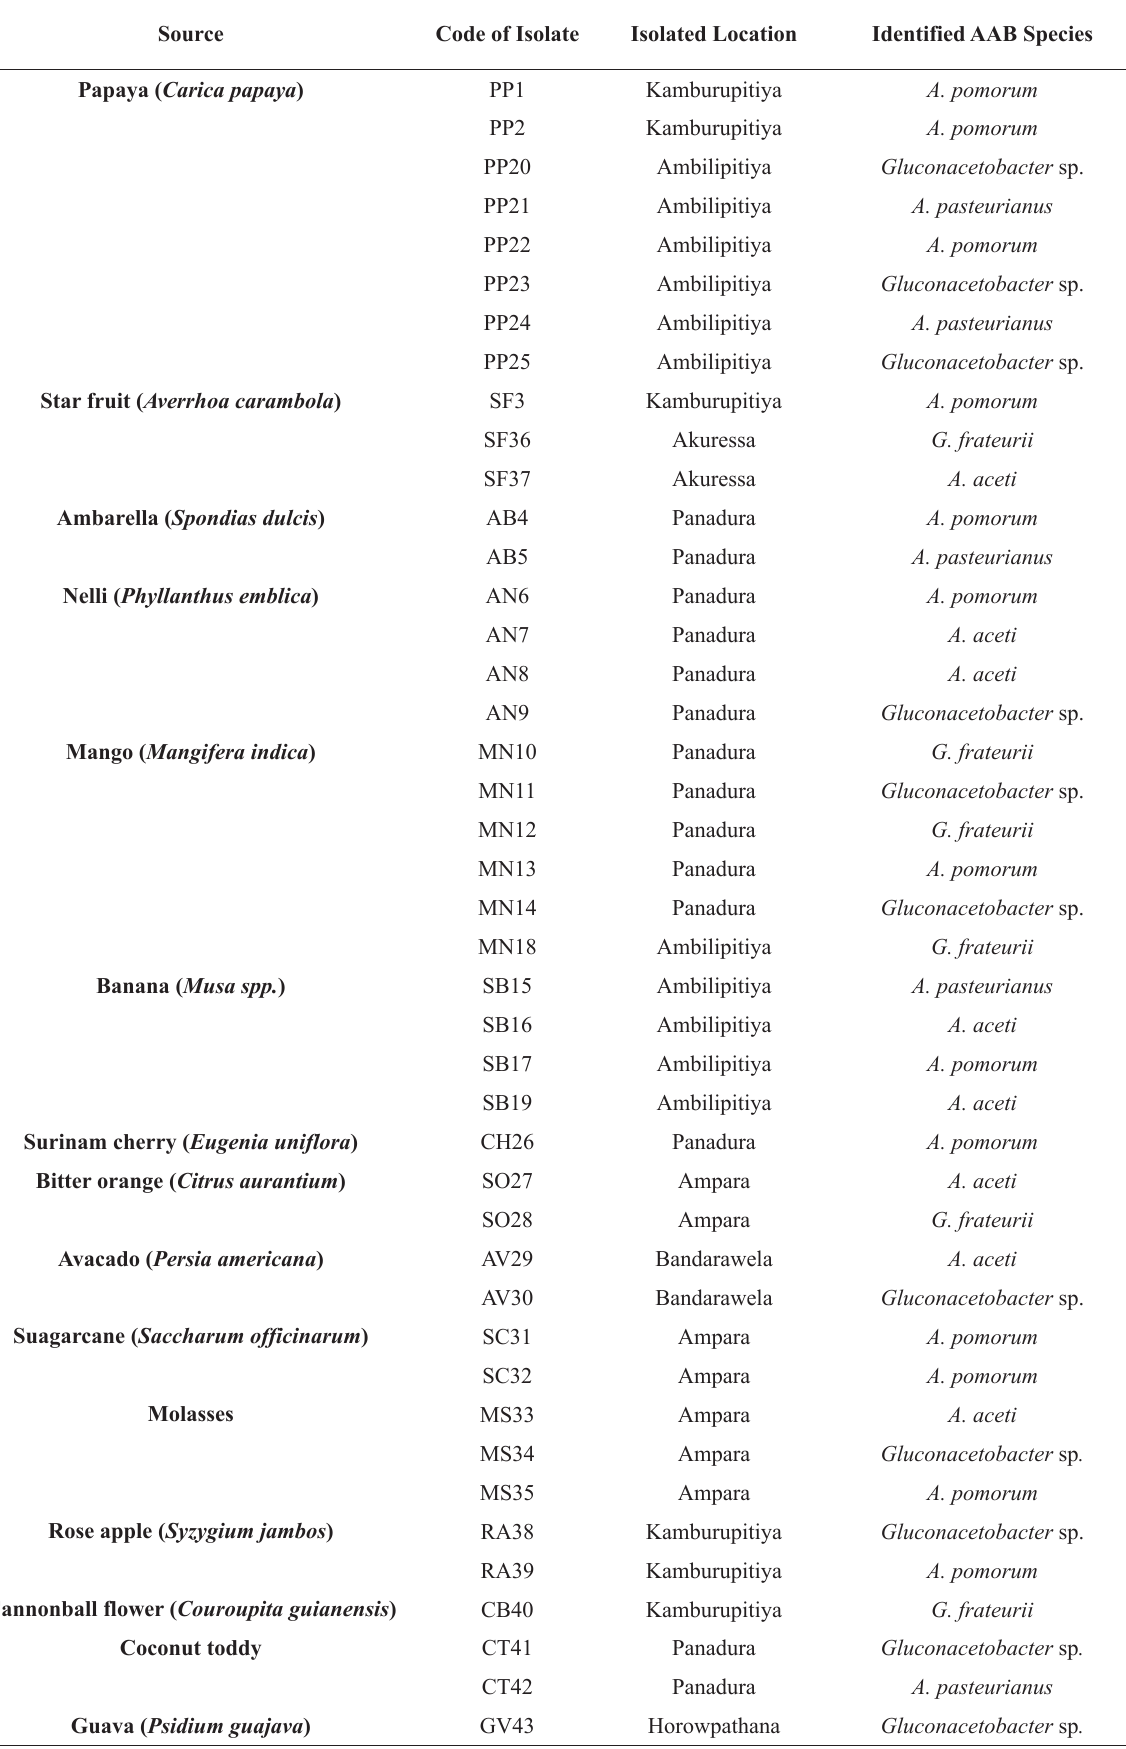
Table 3: Species-level identification of